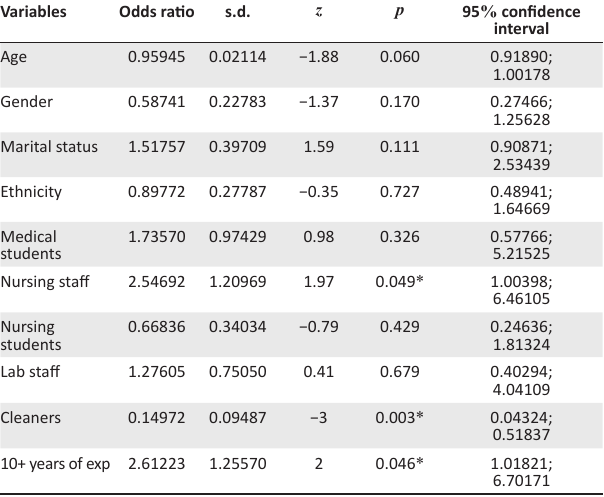
TABLE 4: Factors associated with hepatitis B virus vaccination amongst health workers at Dr George Mukhari Academic Hospital. Variables Odds